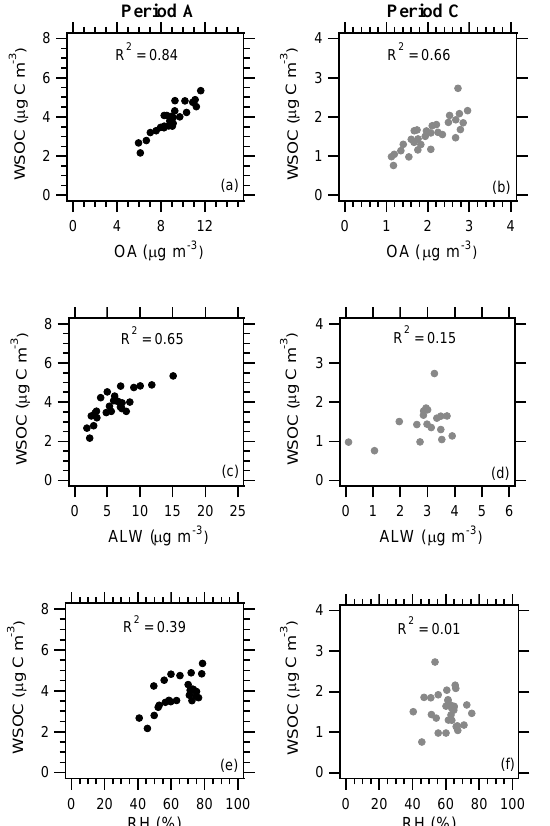
Figure 6. Correlation of hourly averaged WSOC vs. nitrate for (a) Period A and (b) Period C, oxalate for (c) Period A and (d) Pe- riod C, and sulfate for (e) Period A and (f) Period C at SPC. All plots are for during the times of RH increasing.